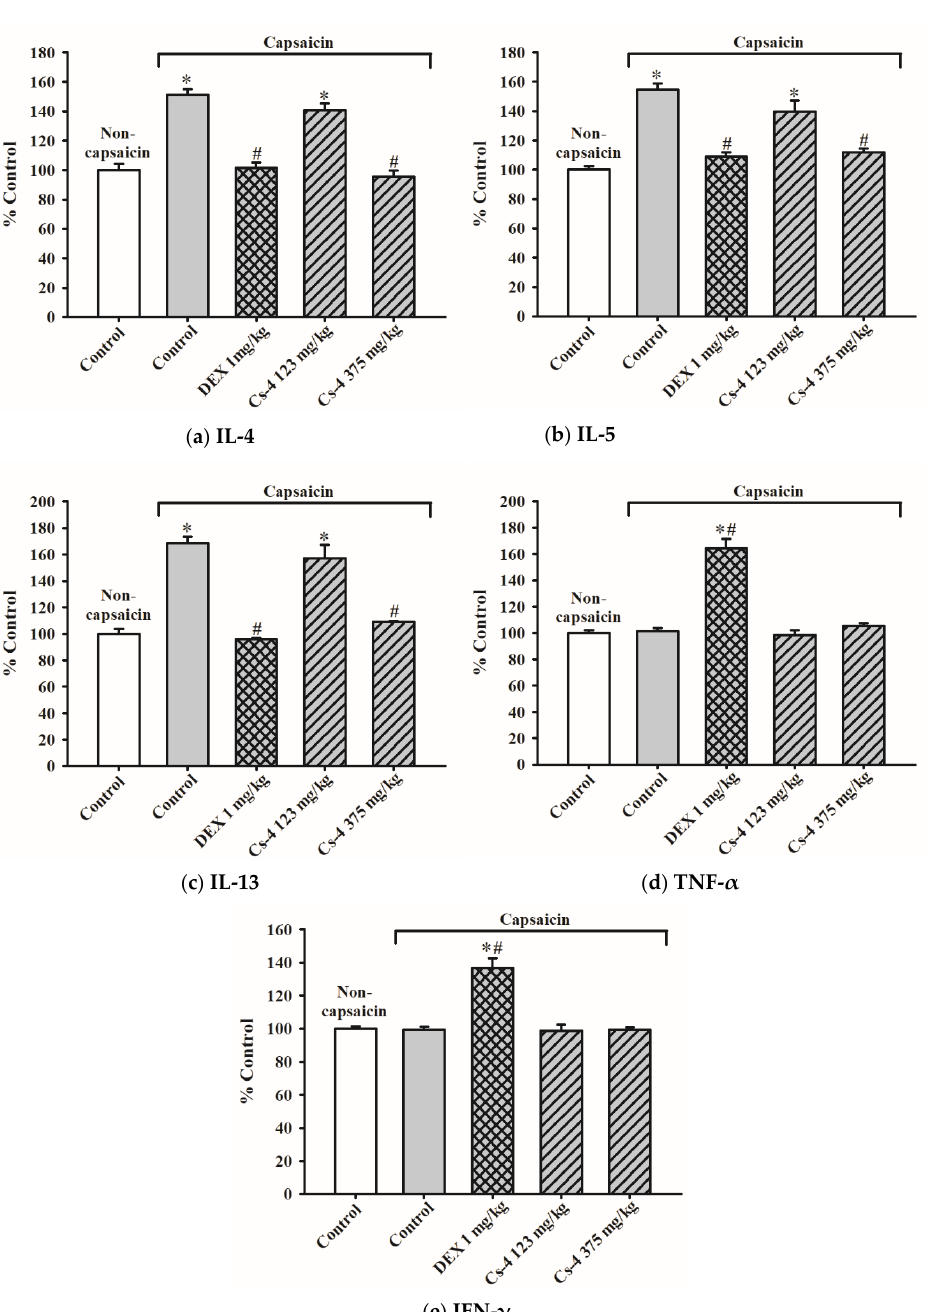
Figure 10. The effect of Cs-4 on various cytokine levels in the lung tissues of capsaicin-challenged rats. Data were expressed as the control percent of noncapsaicin rats, with the control values being ( a ) 367.6 ± 15.9 pg / mL (interleukin (IL)-4), ( b ) 368.1 ± 9.22 (IL-5), ( c ) 18.7 ± 0.67 pg / mL (IL-13), ( d ) 354.8 ± 7.39 pg / mL (tumor necrosis factor (TNF)- α ), and ( e ) 745.6 ± 10.37 (interferon (IFN)- γ ). Each bar represents the mean ± S.E.M., with n = 8. * Significantly di ff erent from the noncapsaicin control group. # Significantly di ff erent from the capsaicin control